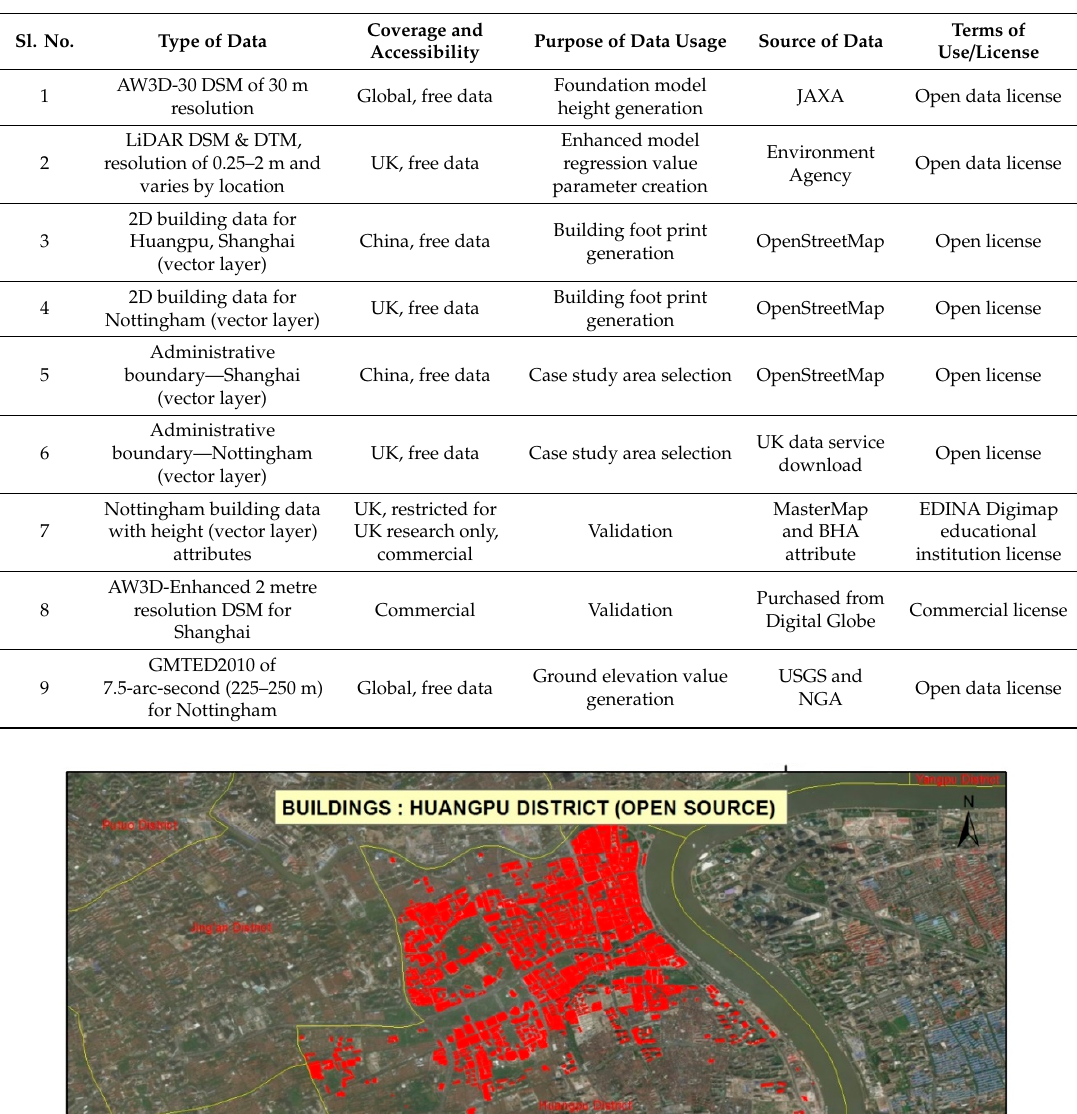
Table 1. Data types and pertinent details.